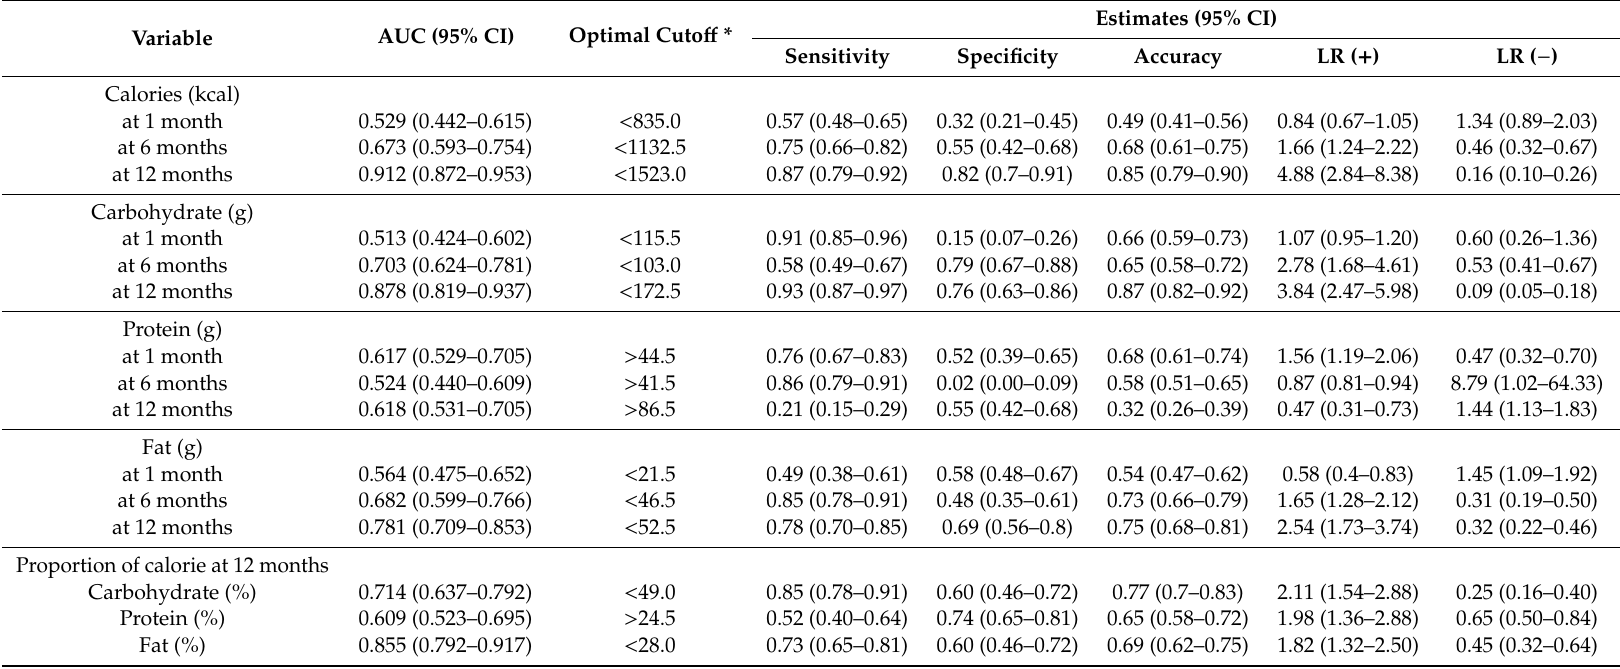
Table 5. Prognostic performance for the success in